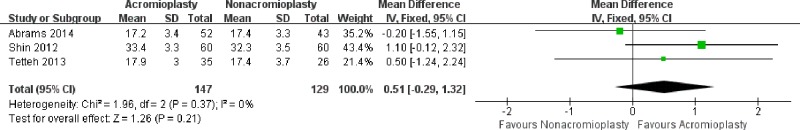
Forest plot of UCLA score between the treatment of acromioplasty and nonacromioplasty.